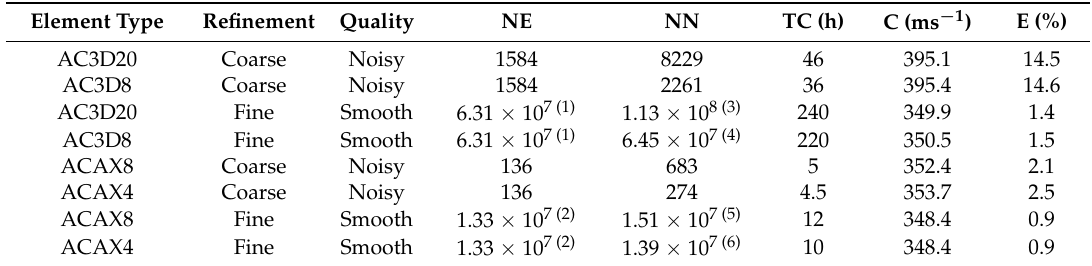
Table 5. Sensitivity analysis- key variable performance evaluation.